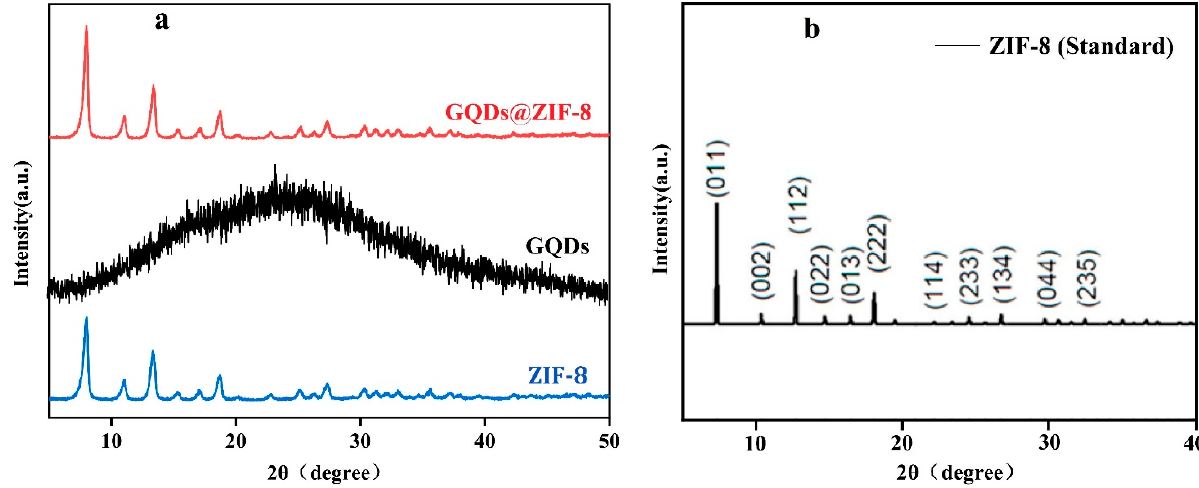
Figure 3. XRD patterns of GQDs, ZIF-8 and the GQDs@ZIF-8 composites. ( a ) Measurement results, ( b ) standard XRD pattern of ZIF-8. Adapted with permission from reference [34]. Copyright 2018, American Chemical Society.